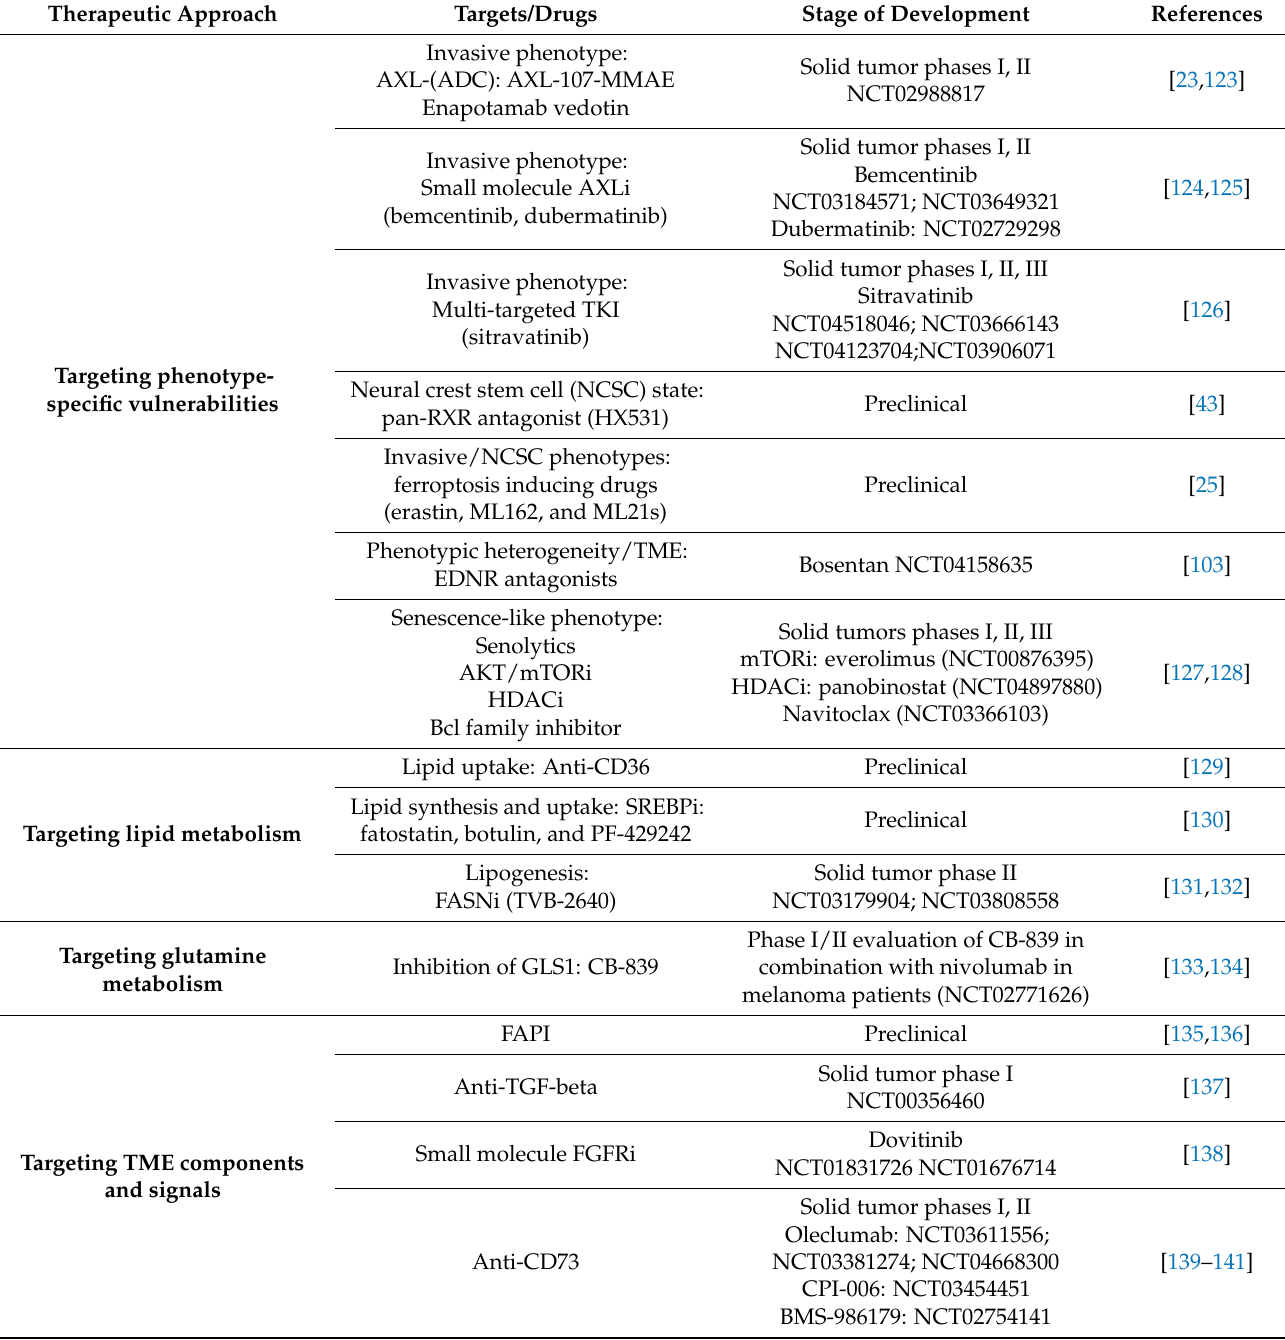
Table 1. Targeting phenotypic plasticity: an overview of innovative and rational approaches for melanoma